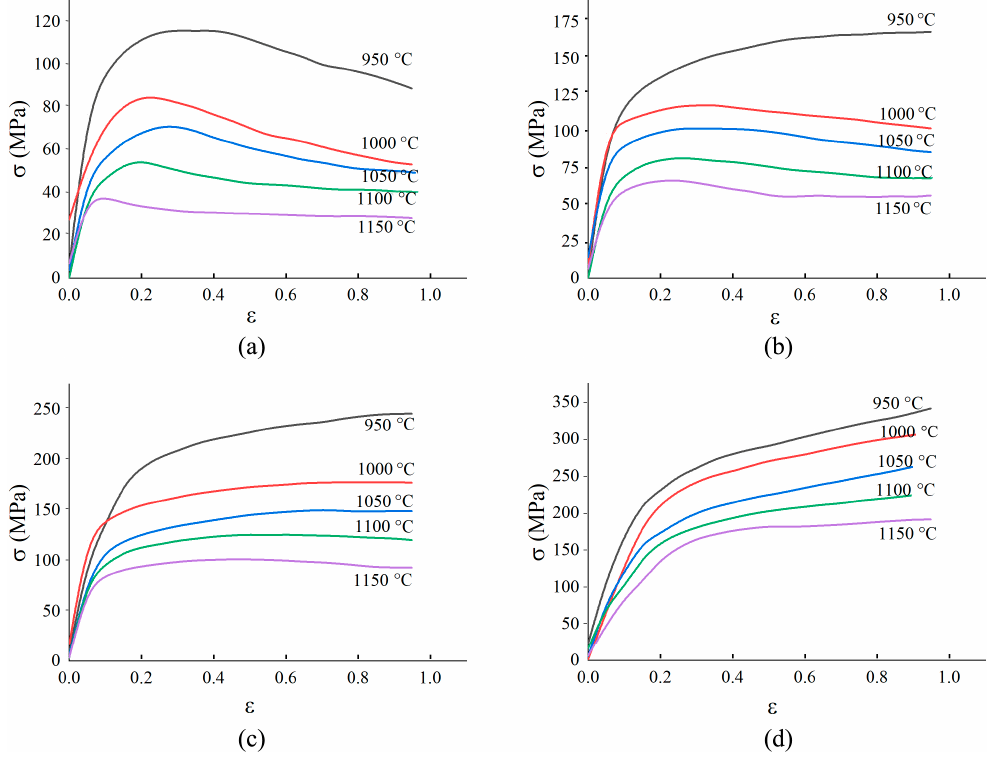
Figure 5. Tensile flow stress of 300M steel under: ( a ) 0.01 s − 1 , ( b ) 0.1 s − 1 , ( c ) 1 s − 1 , ( d ) 10 s − 1 .